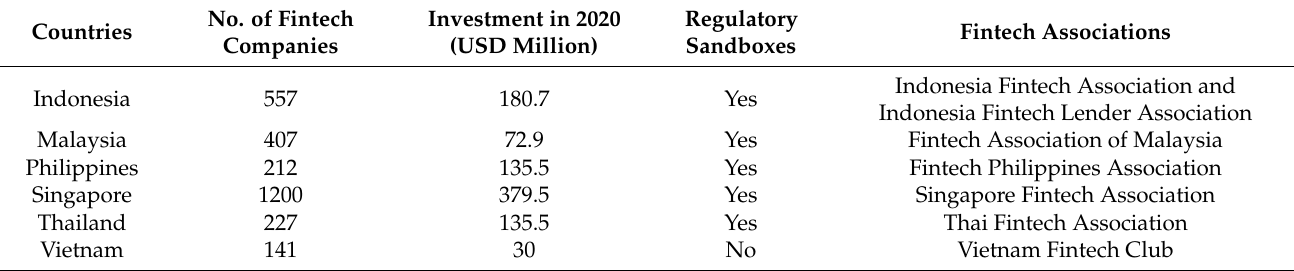
Table 1. Fintech update in six ASEAN